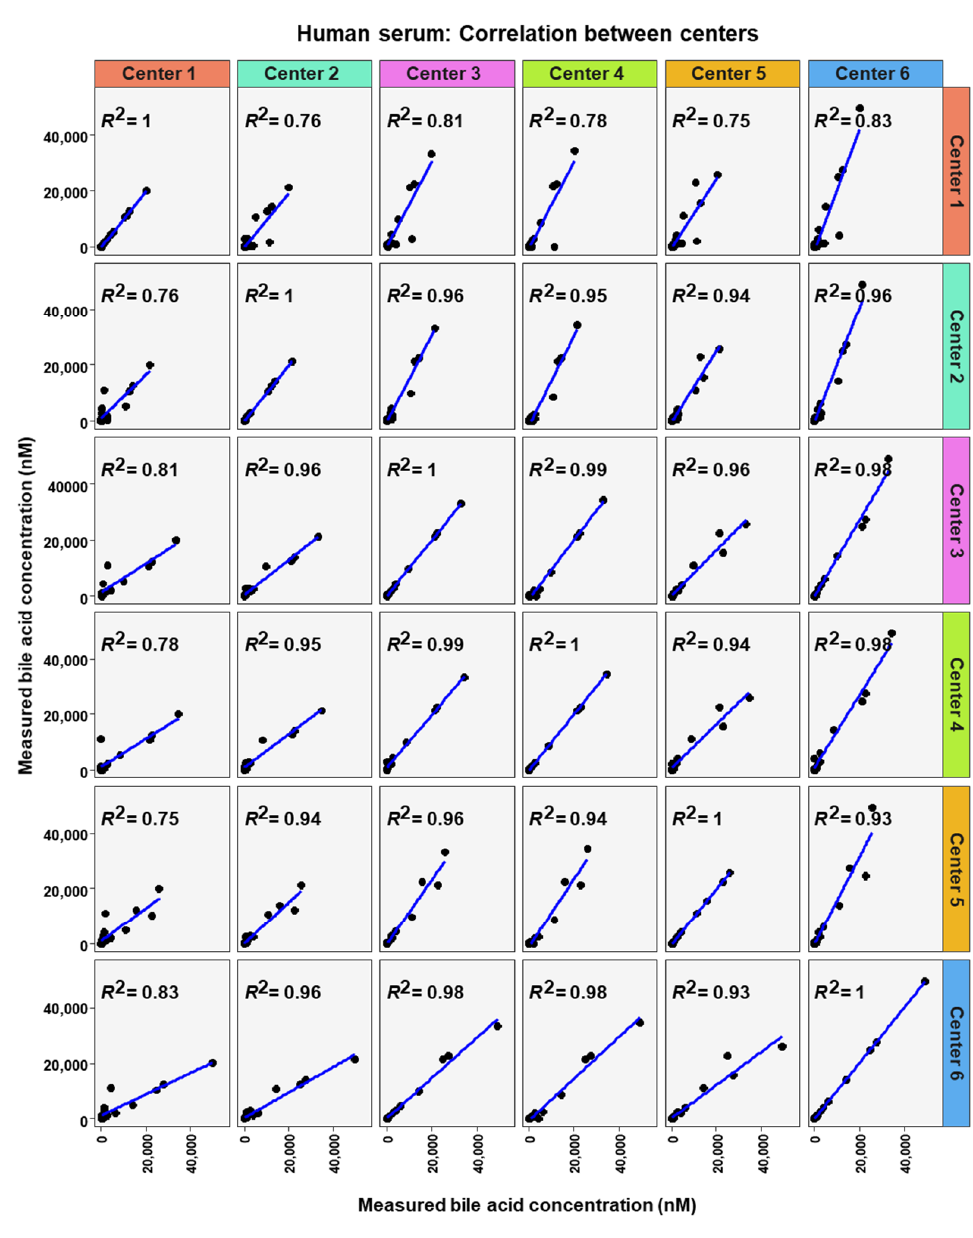
Figure 8. Correlation of bile acid quantification between assessing centers for measurements of bile acid in human serum.